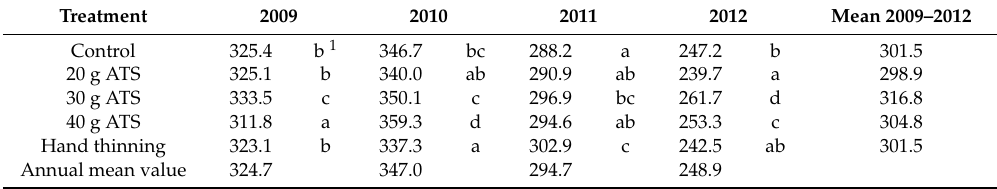
Table 6. The e ff ect of thinning on ‘Regina’ fruit firmness: mean values for 2009–2012.